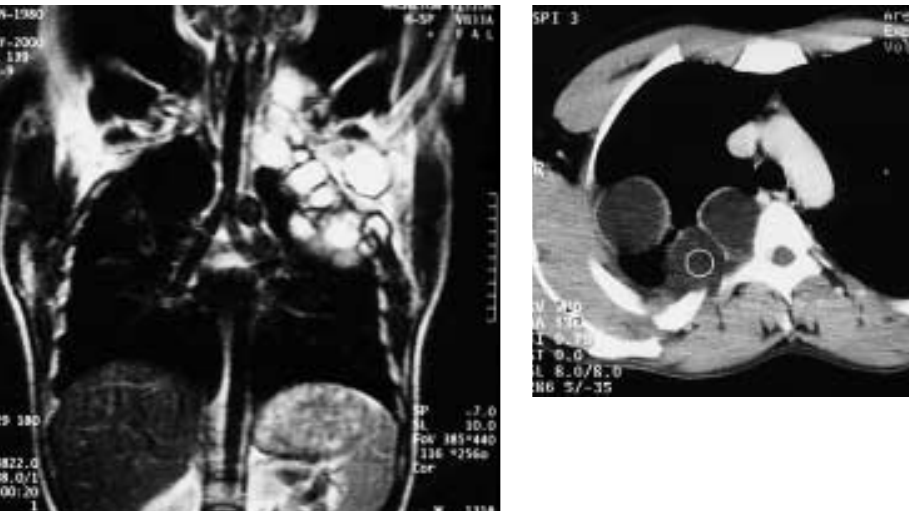
Magnetic resonance imaging of multiple cystic lesions in left cervicothoracic